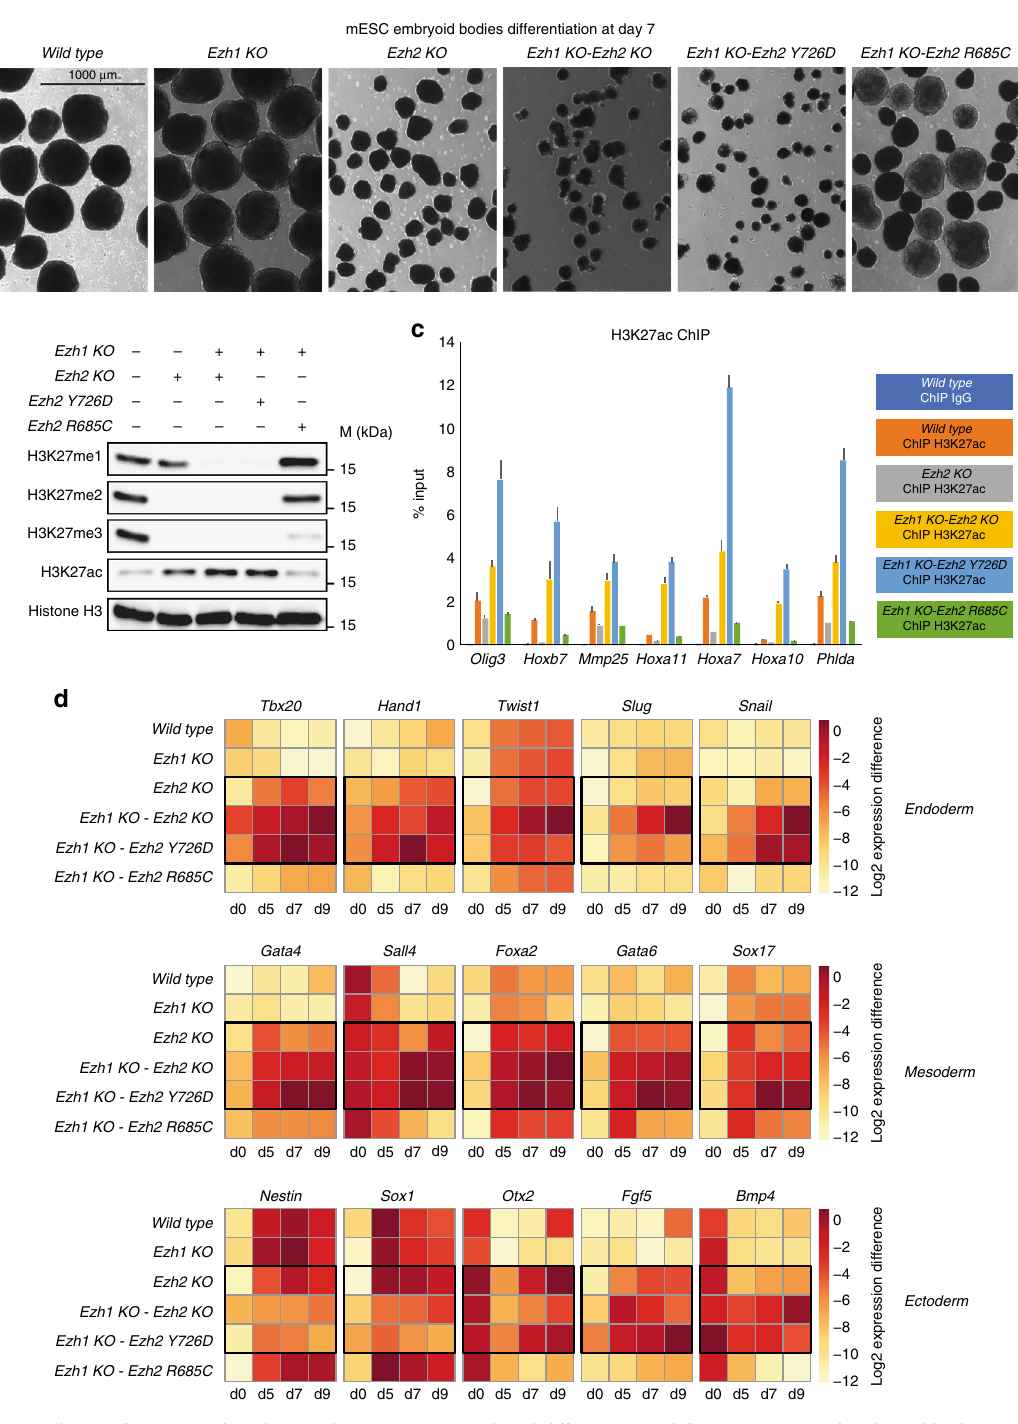
Fig. 7 Diffused accumulation of H3K27ac directly contributes to PRC2-mediated differentiation defects. a Pictures of embryoid bodies at day 7 (d7) of differentiation, from the indicated ESC lines (shown at ×4 magni fi cation). b Western blot analysis using the indicated antibodies with protein extracts obtained from WT, Ezh2 KO, Ezh1/2 dKO, Ezh1 KO- Ezh2 Y726D, and Ezh1 KO- Ezh2 R685C mouse ESC lines. Histone H3 was used as loading control. c ChIP-qPCR of H3K27ac in the indicated mESC lines. IgG rabbit served as negative control. Enrichments are normalized to % INPUT. Data are represented as mean ± SEM. d Heatmaps of qPCR relative expression analyses for the indicated genes at d0, d5, d7, and d9 during ESC differentiation of the cells indicated shown in a . Gapdh expression served as a normalization